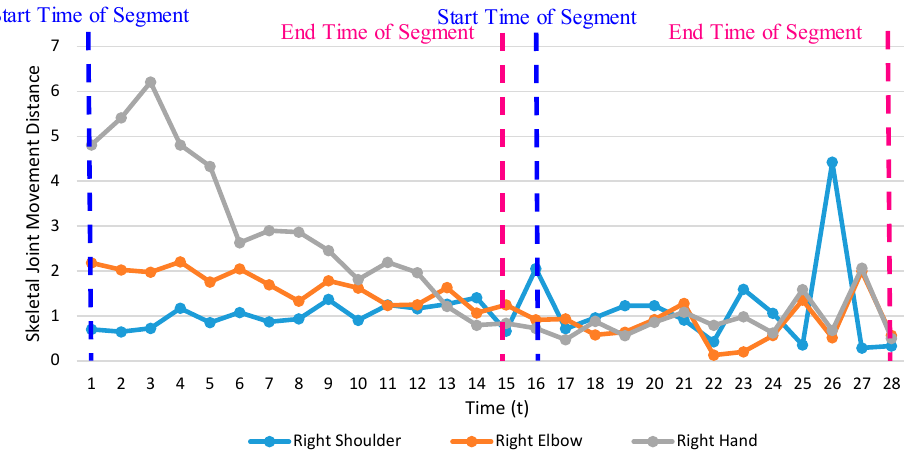
Figure 3. Illustration of temporal segmentation over the skeletal joint movement data.